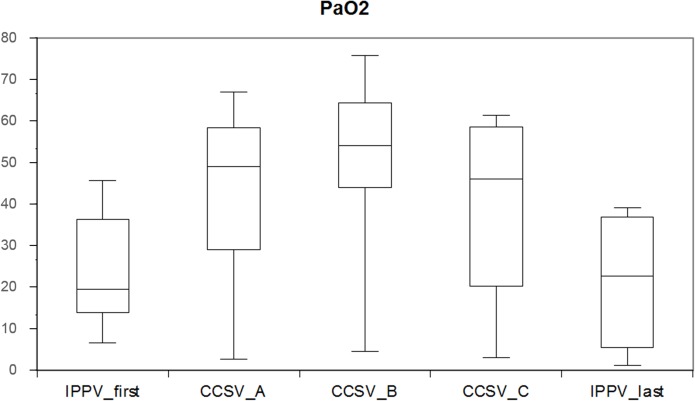
Results of PaO2.Results of PaO2 of IPPVfirst, CCSVA, CCSVB, CCSVC, and IPPVlast (median, 25/75% percentiles, min/max) [kPa].